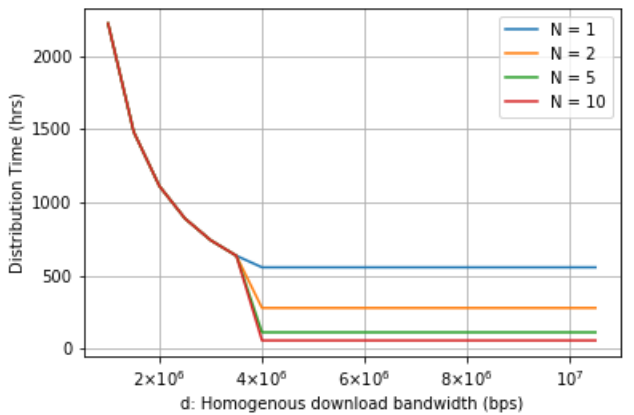
Figure 11. Distribution time while d is varied for some value of